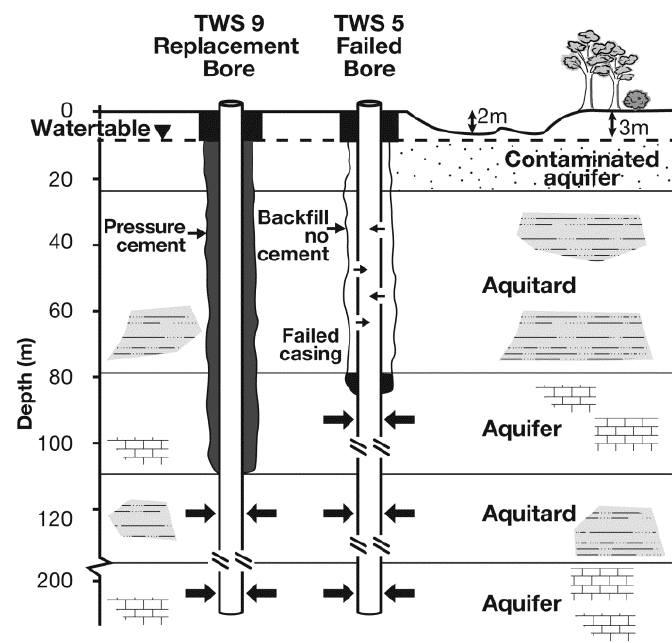
Figure 14. Millicent water supply wells.